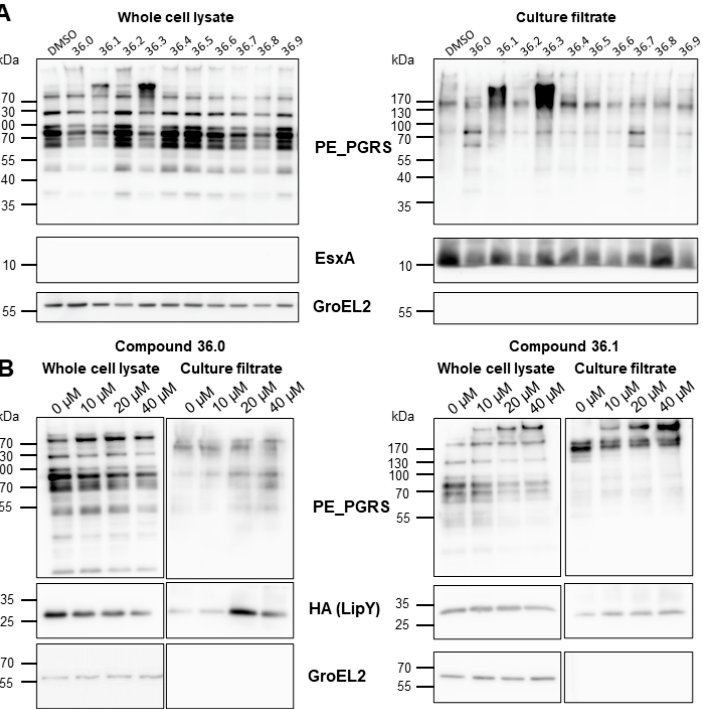
Figure 3. Compound 36 derivatives induced hypersecretion of ESX-5 substrates. ( A ) Secretion analysis of M. marinum transformed with pSMT3-lipY - mspA treated with indicated compounds at 20 μ M. Whole-cell lysates and culture filtrate were separated by SDS-PAGE and analyzed with antibodies against PE_PGRS, EsxA, or GroEL2. ( B ) Secretion analysis M. marinum overexpressing lipY and mspA treated with compounds 36.0 and 36.1 in dose-response from 0 μ M to 40 μ M. Whole-cell lysates and culture filtrate were separated and analyzed with antibodies against PE_PGRS, HA tag, or GroEL2.